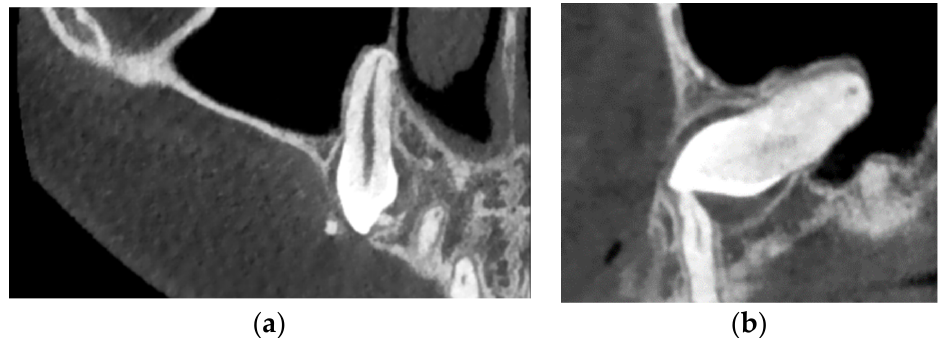
Figure 2. ( a ) The right maxillary canine also has a root DL, presenting a “hook” bend towards the mesial in the apical third of the root. ( b ) “Bull’s eye” phenomena highlighted in the sagittal section. Case 2